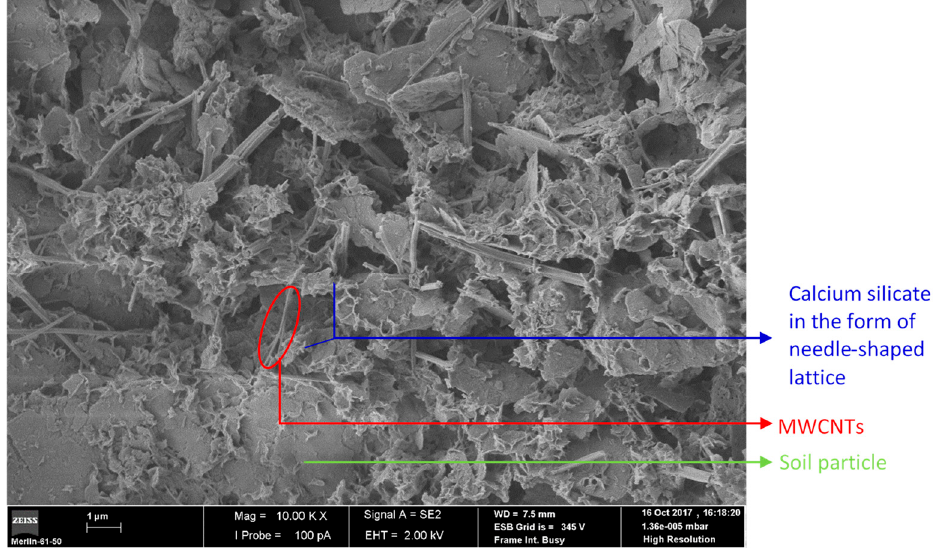
Figure 7. SEM image of a chemically stabilized soil sample additivated with MWCNTs (0.01%) dispersed in a solution of Amber 4001 (3%) for 7 curing days.